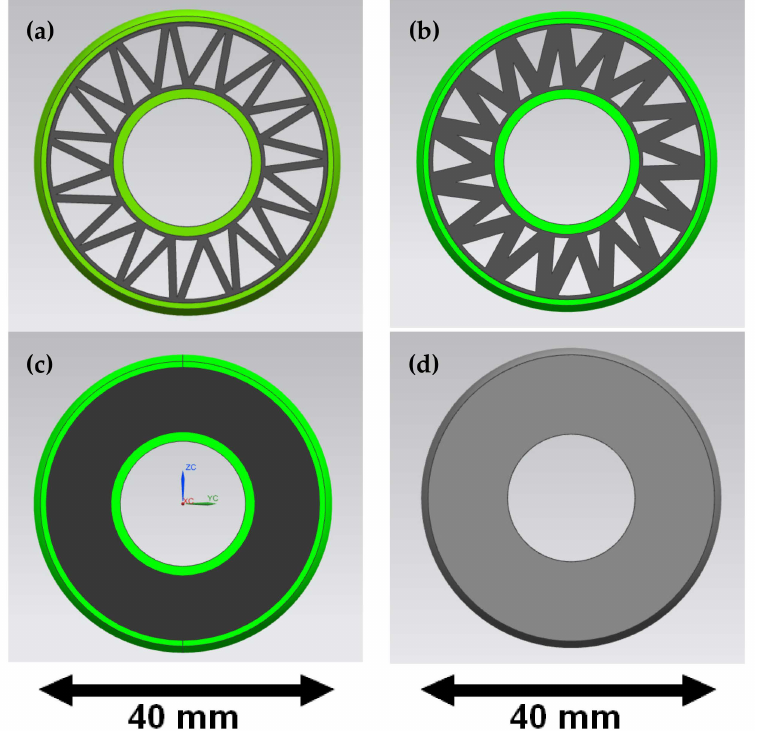
Figure 2. Geometries of the bushings—PLA-TPU with 1 mm V-shaped filling ( a ), PLA-TPU with 2 mm V-shaped filling ( b ), PLA-TPU with full TPU filling ( c ), steel bushing ( d